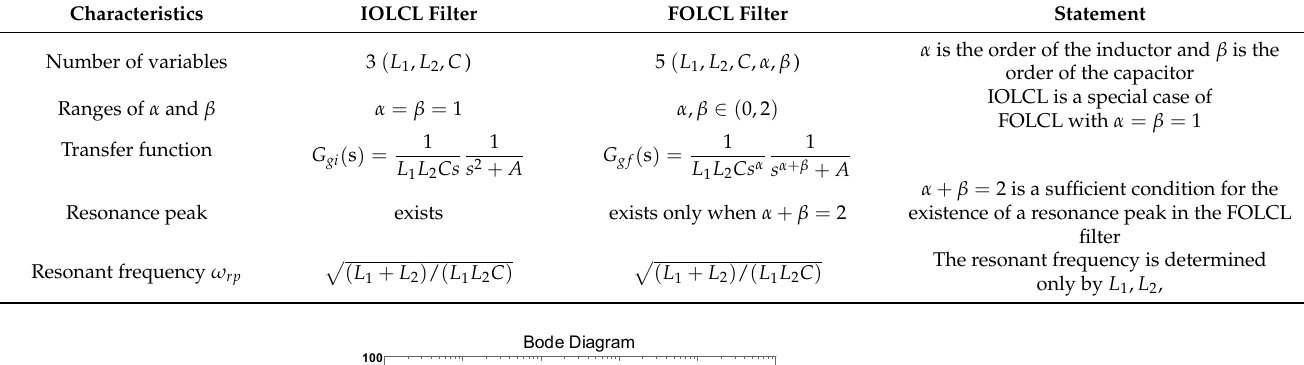
Table 1. Characteristics comparison of IOLCL and FOLCL filters.